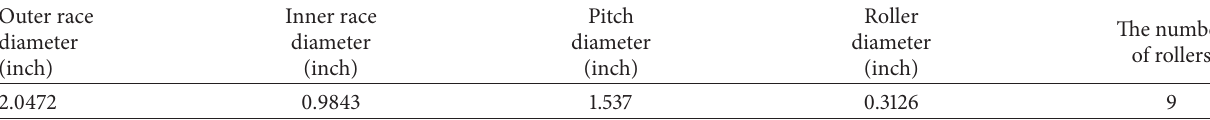
Table 1: Geometry information of the test bearing.